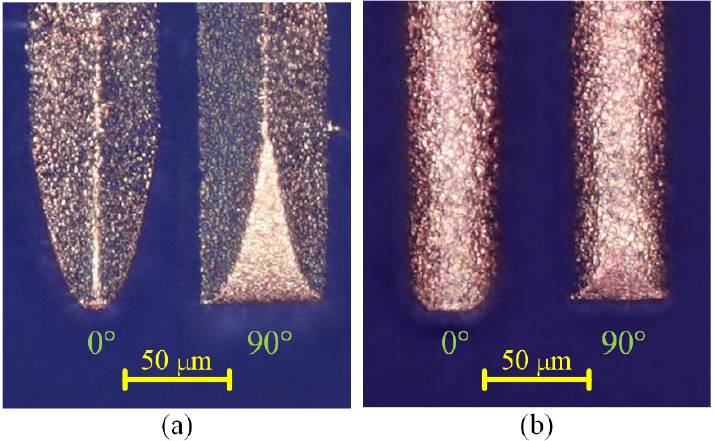
Figure 22. Optical images of the two electrodes in Exp. 3: ( a ) square electrode-rotate 45° in advance-nonrotating mode; ( b ) cylindrical electrode-nonrotating mode.